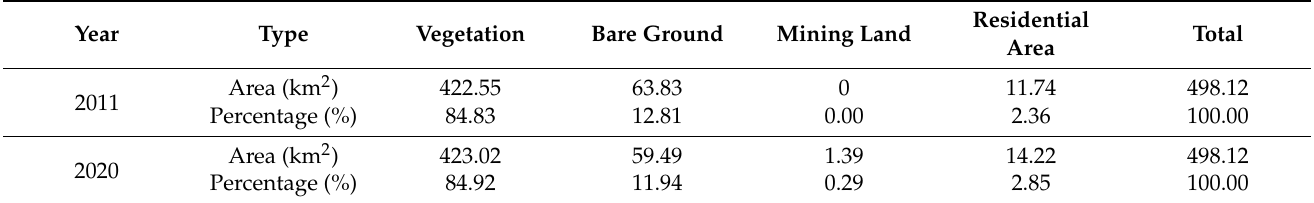
Table 6. Ecological resources in the monitoring area of Taldybulak